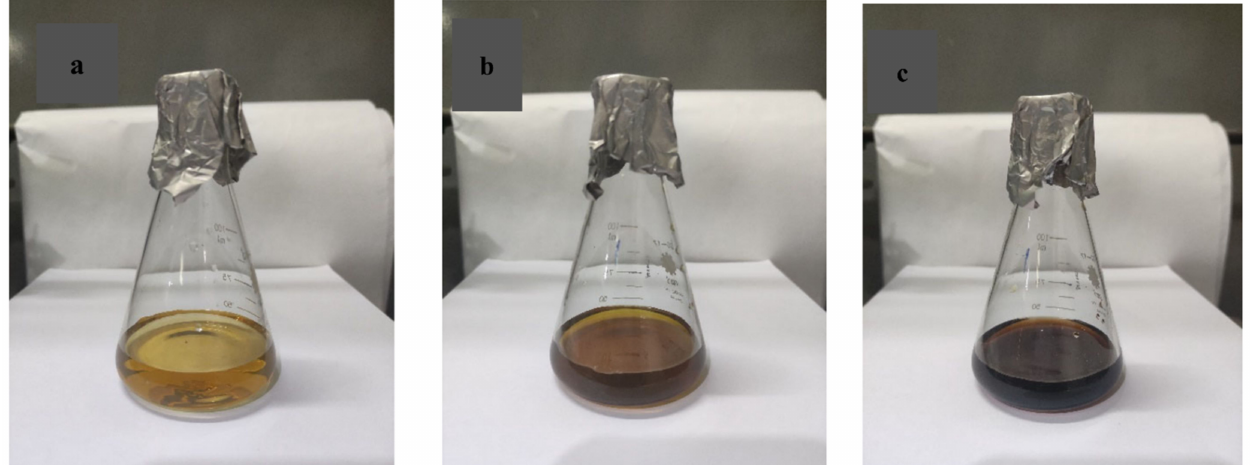
Figure 1. Color change observed after each 10 min escorted out by their UV-Vis spectrum given below (( a – c ) pictures taken at 0, 10, and 20 min,